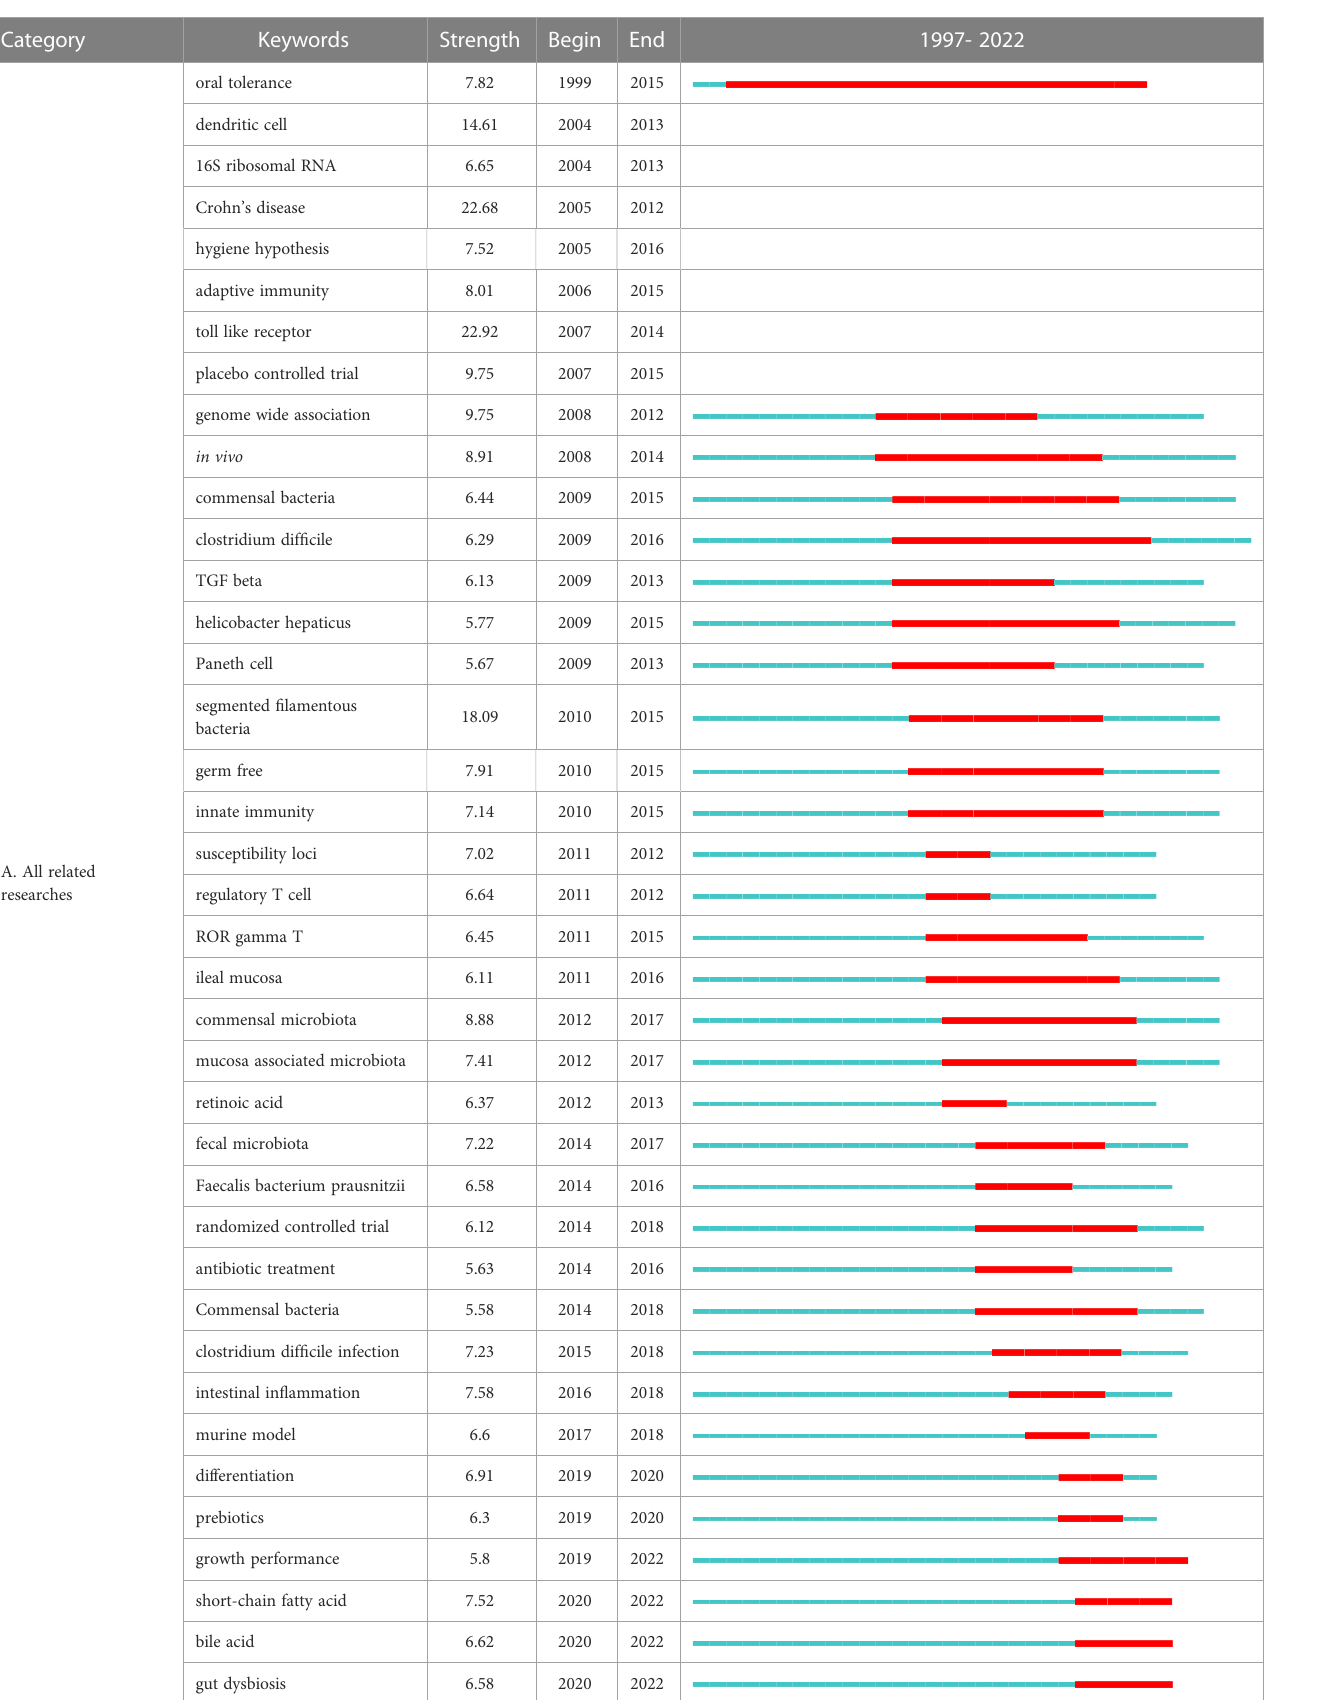
TABLE 3 Emergent analysis of keywords in relevant literature.